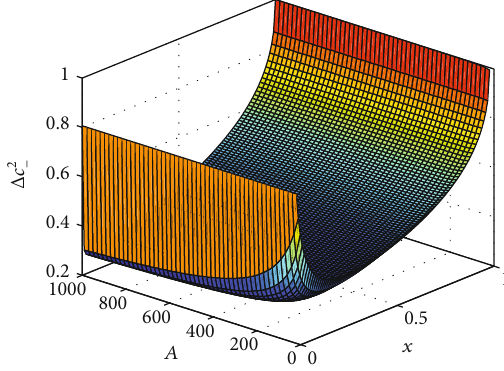
ffi cient − versus the linear gain coe